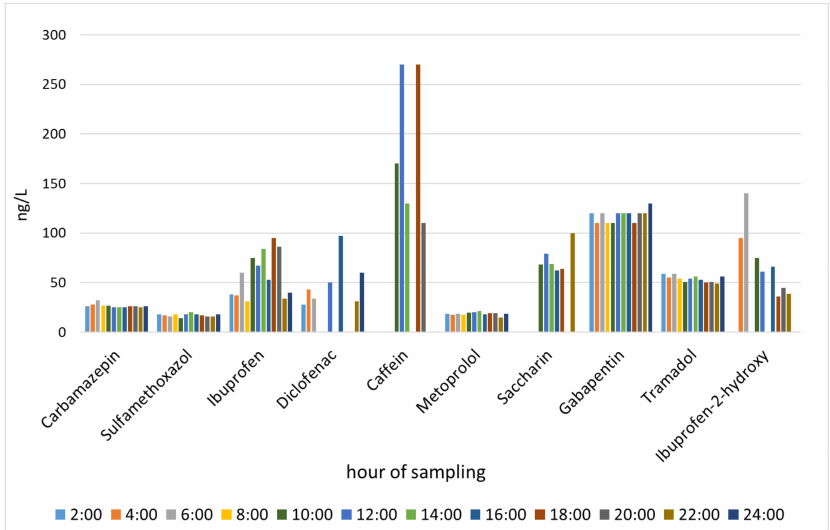
Figure 7. Time-related changes in concentrations of selected PPCPs on profile No. 5 during August